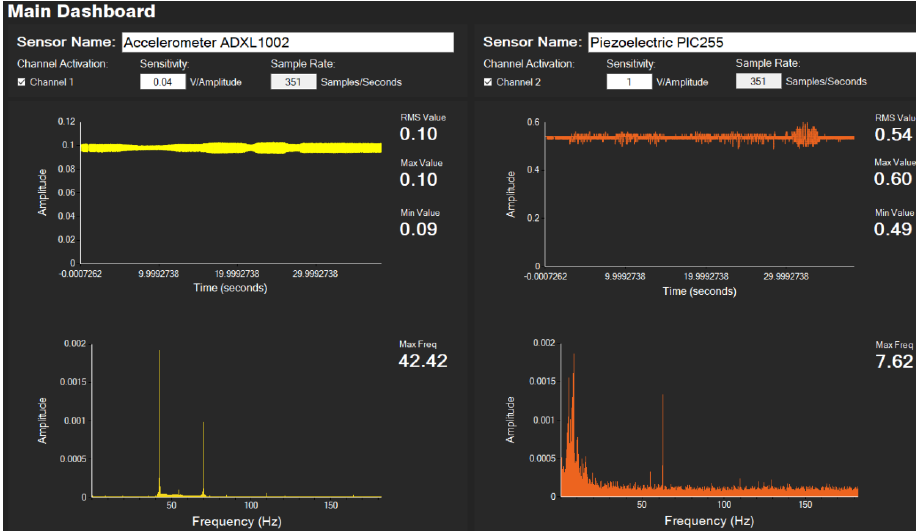
Figure 11. Main UI data visualization.